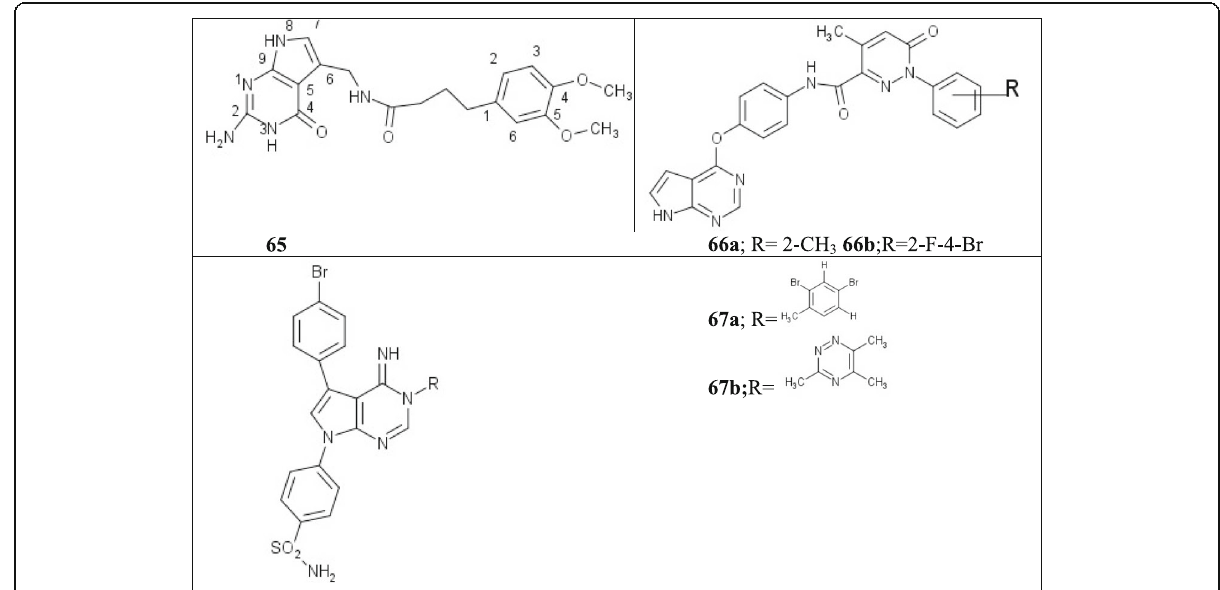
Fig. 21 Chemical structure of pyrrolo-pyrimidine derivatives